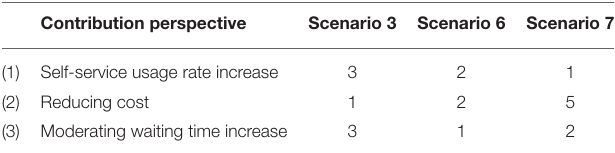
TABLE 7 | Comprehensive scenario